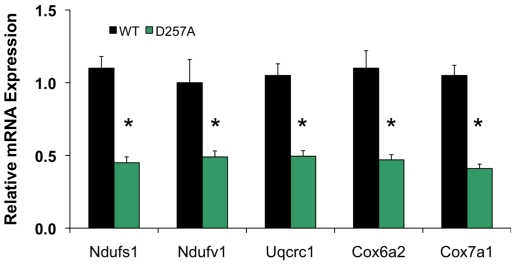
D257A mice display decreased mRNA expression of nuclear genes encoding components of ETC Complexes I, III and IV.Relative mRNA expression of genes encoding components of the ETC complexes I, III and IV, including Ndufs1, Ndufv1, Uqcrc1, Cox6a2, and Cox7a1 was measured in the skeletal muscle from WT and D257A mice at 13 months of age by quantative RT-PCR (n = 5 per group). Mean values ±SEM are shown. *p<0.05.